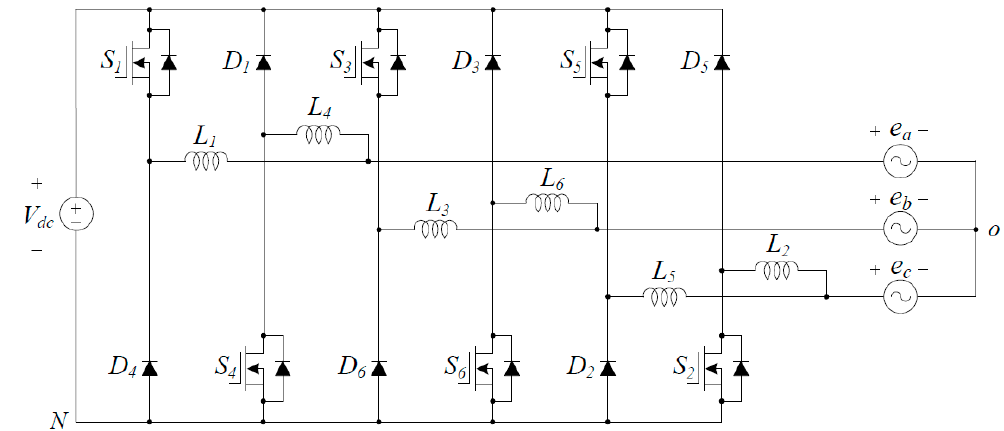
Figure 1. Circuit diagram of the conventional three-phase split-output inverter.